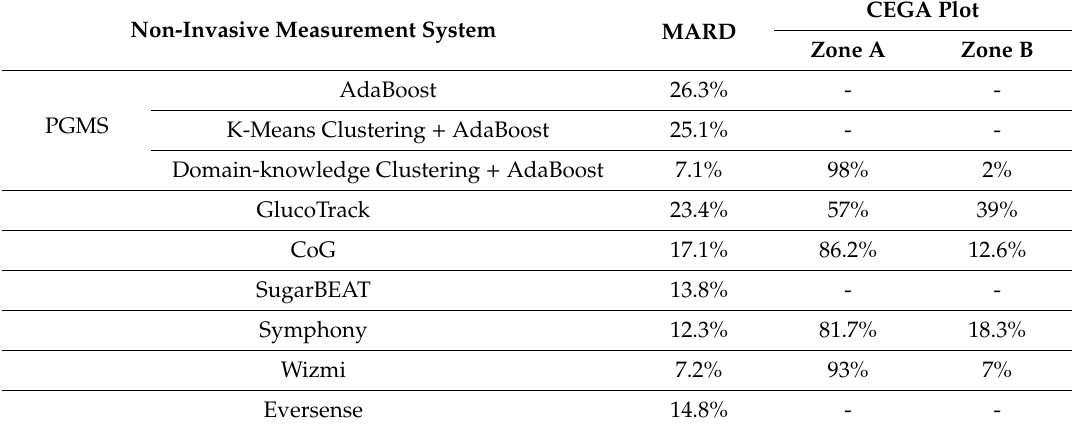
Table 14. Performance comparison of PGMS with other non-invasive or minimal-invasive